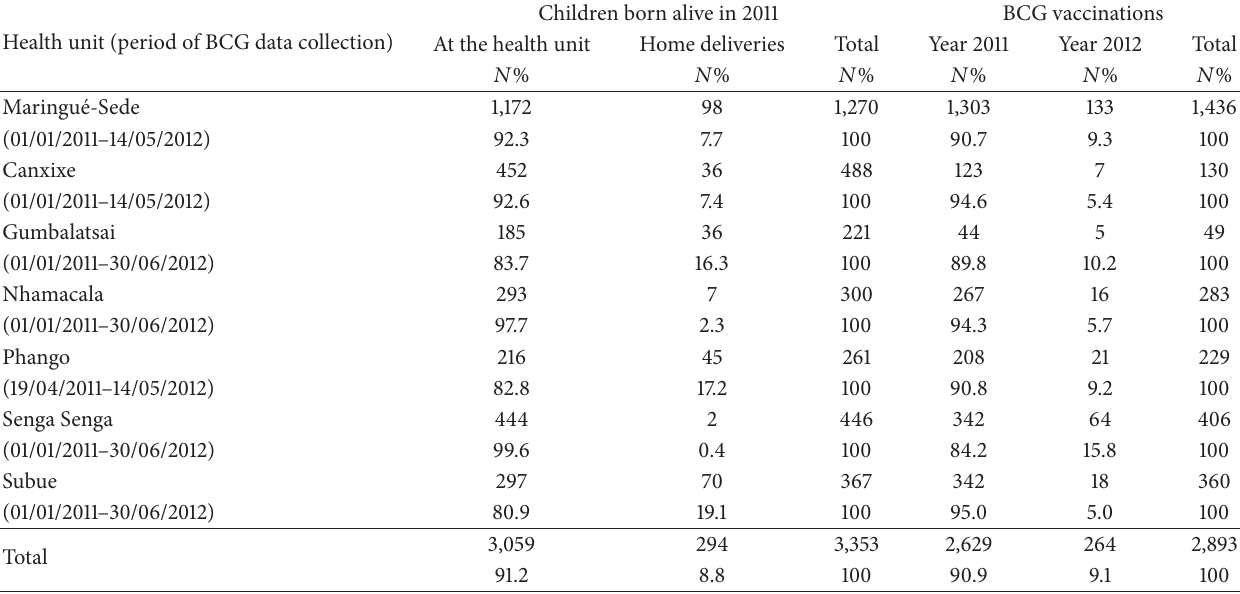
Table 1: Number of children born in 2011 and of Bacille Calmette-Gu´erin (BCG) vaccinations administered to them in the period 01/01/2011– 30/06/2012 in the Maringue District, Sofala Province,